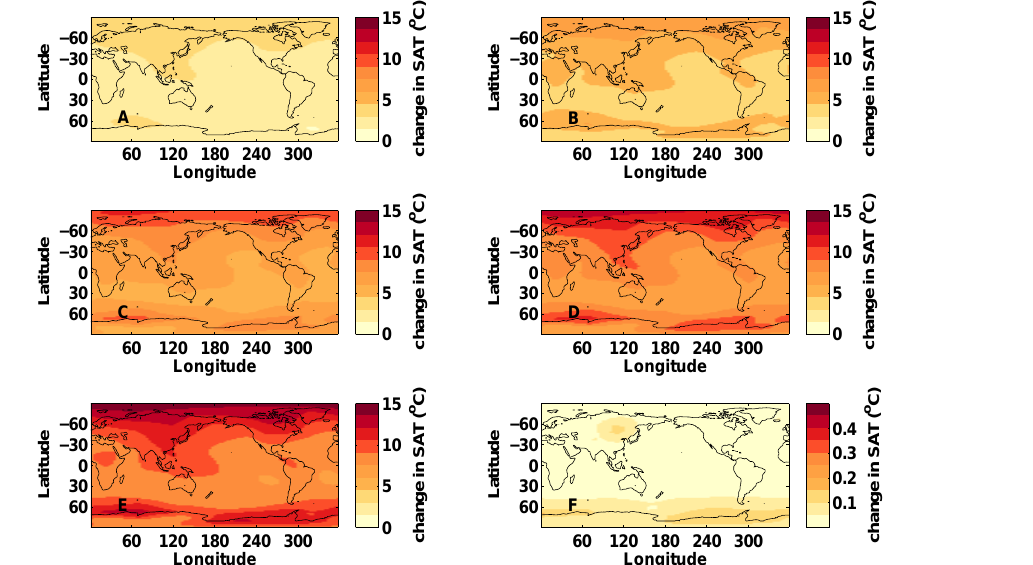
Figure 4. Year-3000 surface air temperature (SAT) anomalies relative to 1800 for select scenarios. (a) 1275GtC FAST, (b) 2275GtC FAST, (c) 3275GtC FAST, (d) 4275GtC FAST, (e) 5275GtC FAST, and (f) 5275GtC PULSE minus SLOW. Note that the color scale for (f) is different from that for the other